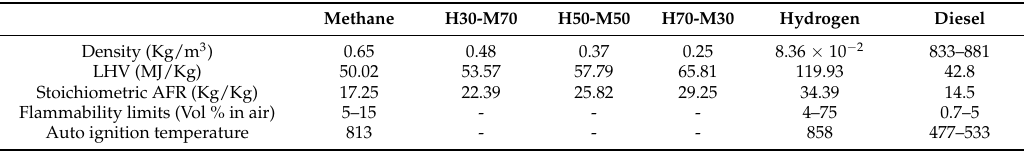
Table 4. Diesel and Gaseous fuel properties [44,47].